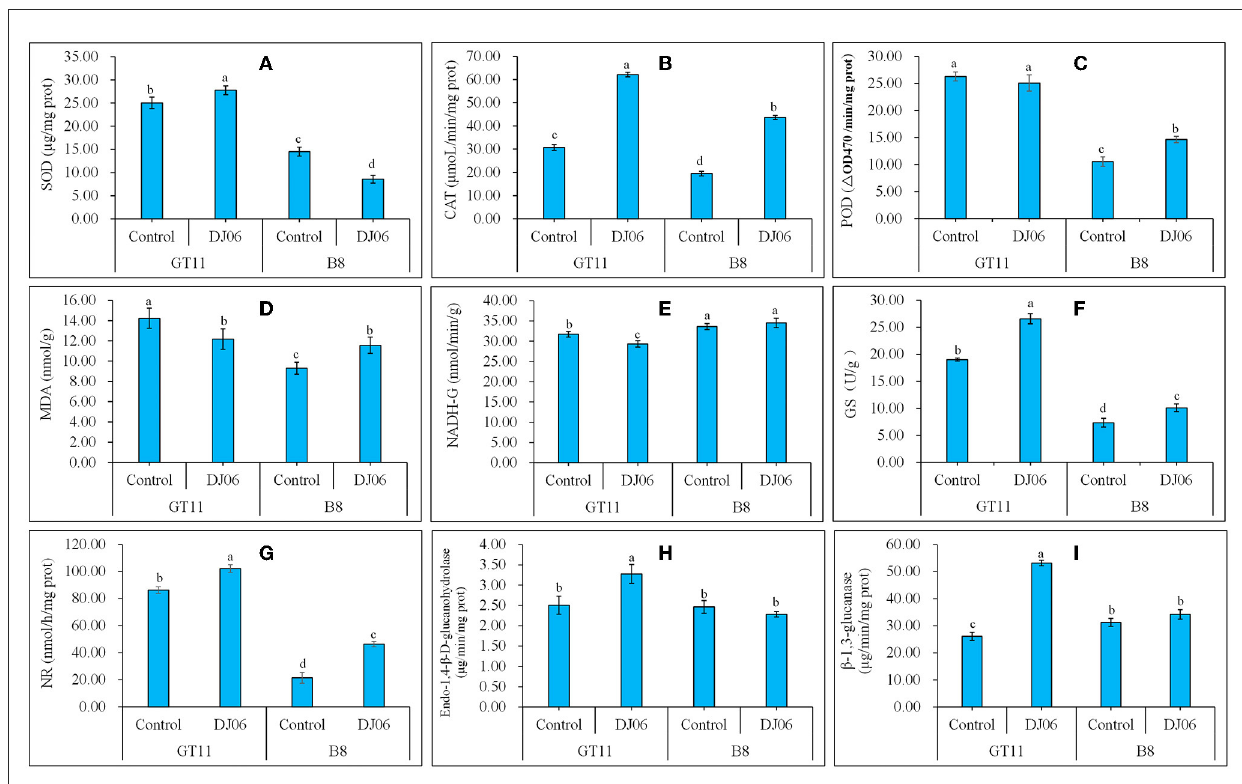
FIGURE7 The activities of various physiological enzymes and the content of MDA in sugarcane varieties GT11 and B8 60 days after inoculation with Pseudomonas aeruginosa DJ06 compared with the control. (A) SOD; (B) CAT; (C) POD; (D) MDA; (E) NADH-GDH; (F) GS; (G) NR; (H) Endo-1,4- β -D-glucanohydrolase; (I) , β -1,3-glucanase. The same letter indicated that no significant difference was detected at Duncan’s multiple range test, P ≤ 0.05 ( n =